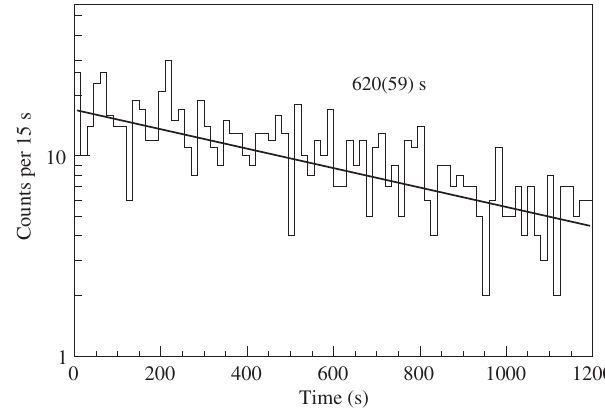
FIG. 16. Time behavior of the 5806-keV α decays of 219 Po during a 1200-s decay-only period of an implanted sample.